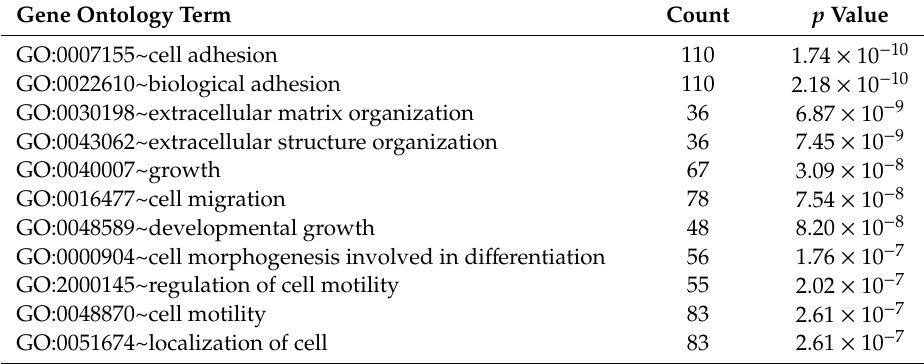
Table 2. The identified protein coding genes involved in biological process.